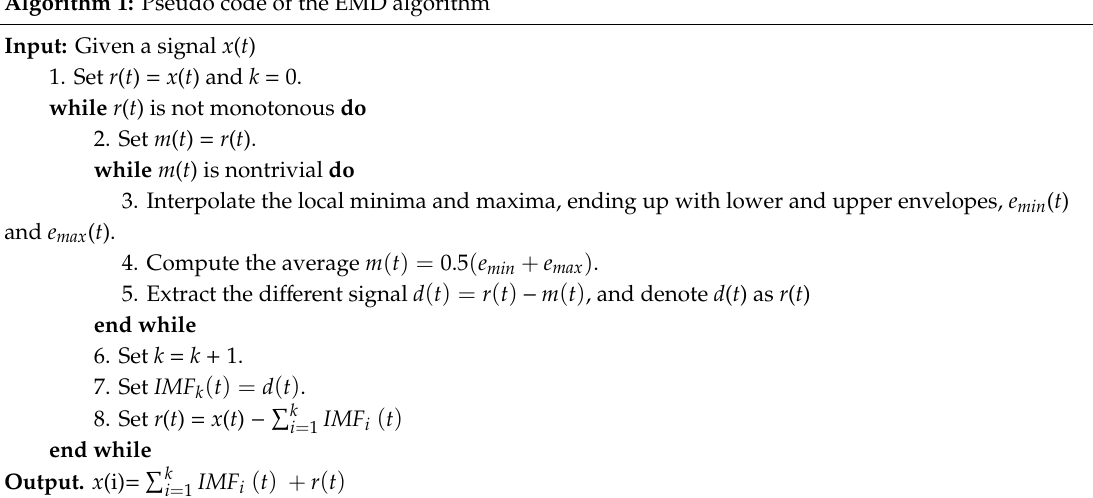
Algorithm 1: Pseudo code of the EMD algorithm